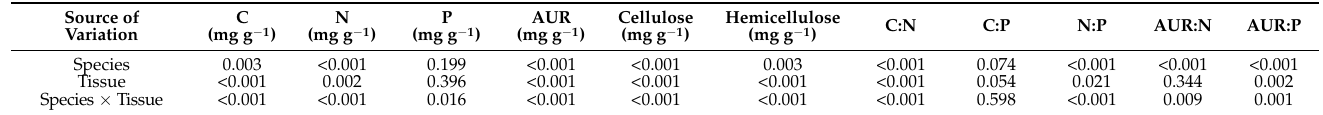
Table 2. Results ( p -values) of the two-way ANOVA showing the effects of species, tissue, and their interactions on the initial chemical properties of four decomposition substrates.